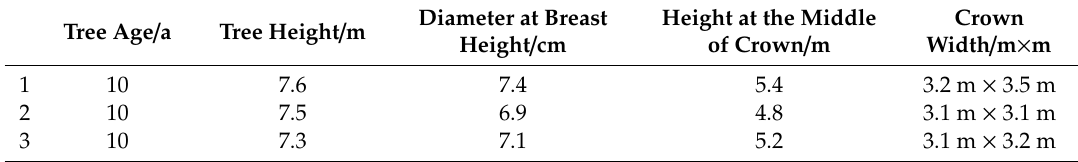
Table 2. Measurement index of the selected trees. Tree Age / a Tree Height /